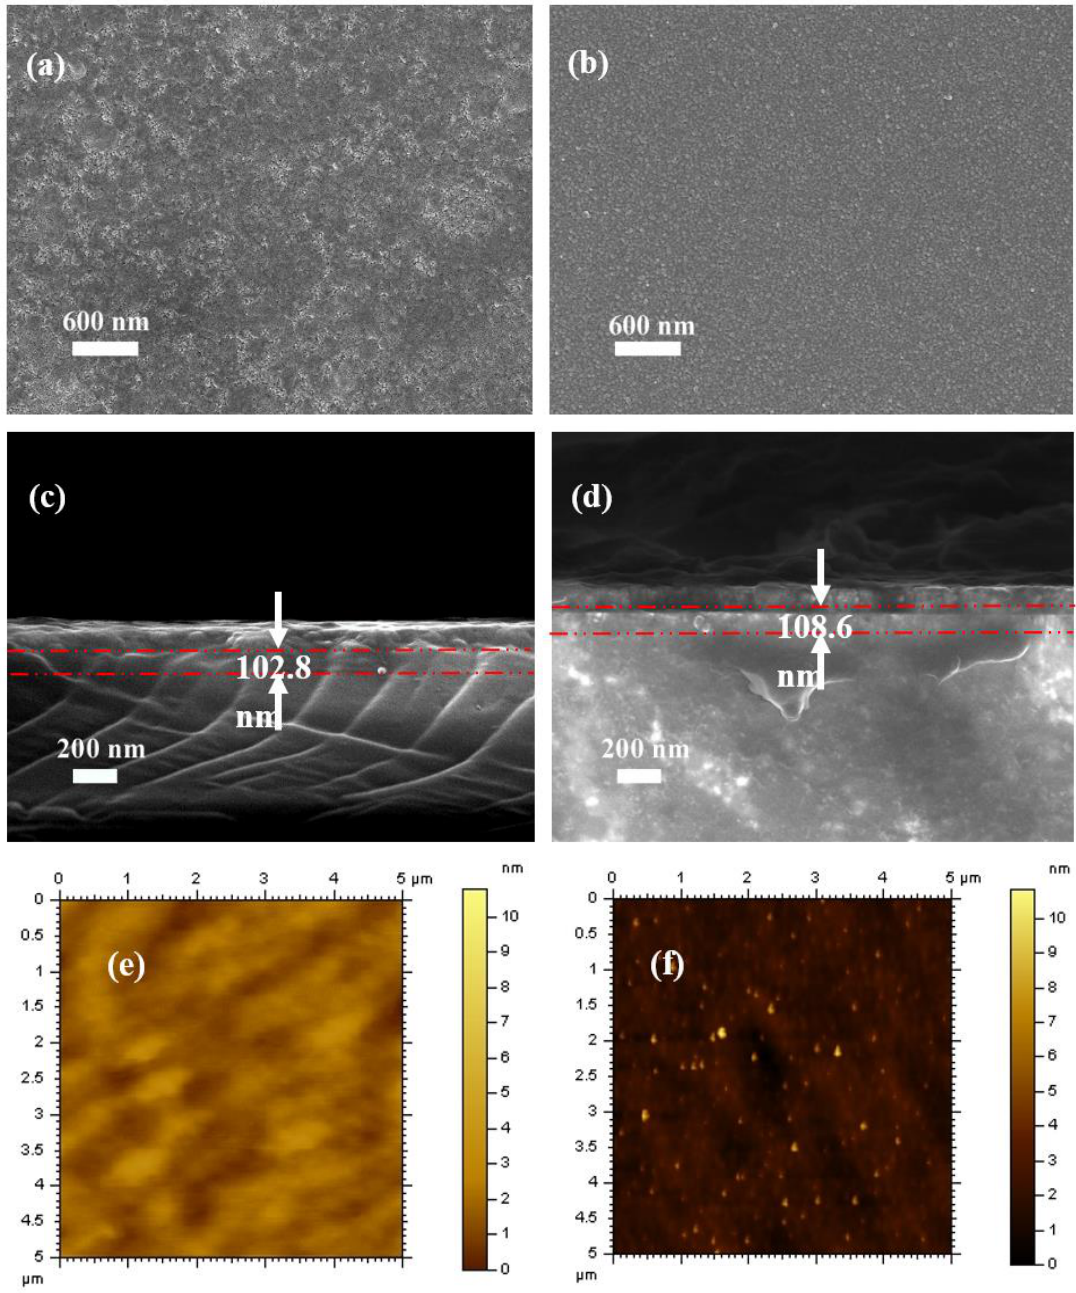
Figure 2. ( a , b ) are SEM images of the as-grown ZnO thin films on quartz glass and sapphire (001) substrates annealed at 600 ◦ C for 1 h, respectively. ( c , d ) are their cross-section SEM images, respectively. ( e , f ) are their corresponding AFM images, respectively.